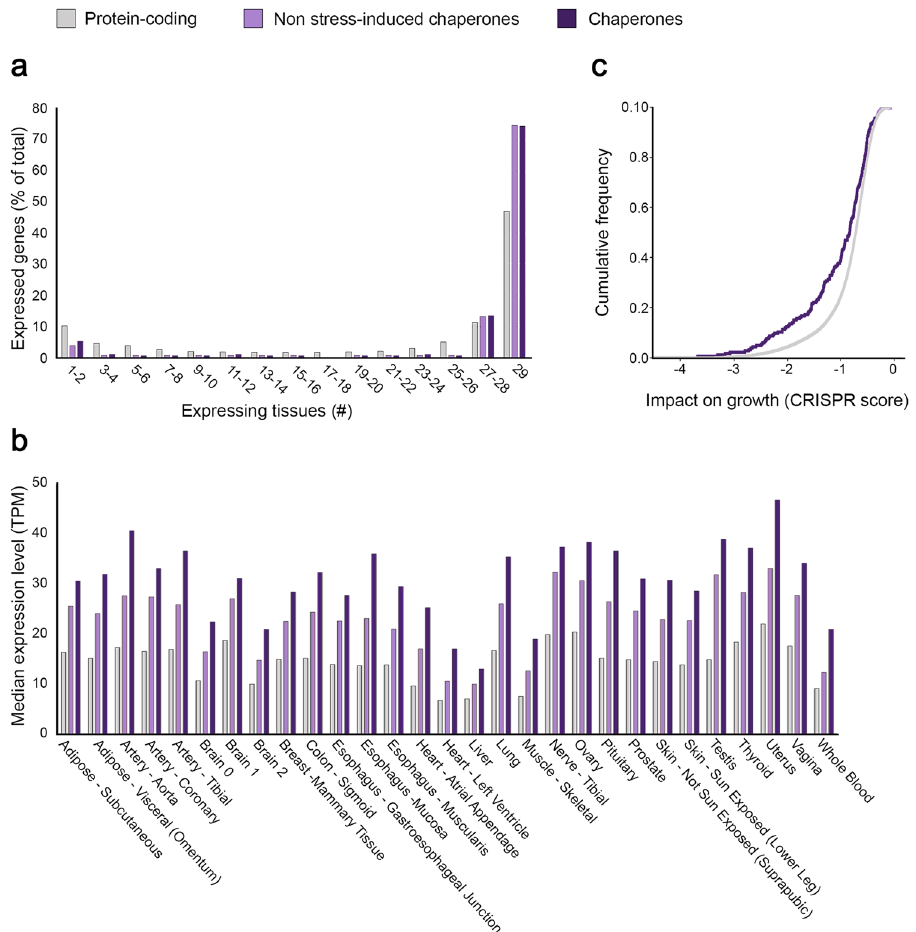
Fig. 1 Chaperones are broadly expressed across human tissues. a The distribution of 194 chaperones, 130 non-stress-induced chaperones and 17,689 other protein-coding genes by the number of tissues expressing them at a level ≥ 1 transcripts per million (TPM; the fi rst bin represents genes expressed in a single tissue or two tissues, the second bin represents genes expressed in three or four tissues, etc.). Chaperones and non-stress-induced chaperones were signi fi cantly more broadly expressed than other protein-coding genes ( p = 2.7E − 9 for both, two-sided Kolmogorov – Smirnov test). b The median expression levels per tissue of chaperones, non-stress-induced chaperones and other protein-coding genes. Only genes expressed at a level ≥ 1 TPM were considered. Chaperones and non-stress-induced chaperones tend to be signi fi cantly more highly expressed across all 29 tissues (adjusted p between 1.7E − 7 and 1.4E − 19, and adjusted p between 0.026 and 4.9E − 8, respectively, two-sided Mann – Whitney test). Chaperones n = 155 – 192; non-stress-induced chaperones n = 102 – 129; other protein-coding genes n = 10,689 – 15,555. c The cumulative distribution of the impact on growth of 186 chaperones and 17,932 other protein-coding genes, measured in 769 cell lines harboring CRISPR-induced gene inactivation (CRISPR score). Each gene was associated with its minimal CRISPR score. Chaperones were signi fi cantly more important for growth than other protein-coding genes ( p = 1.5E − 5, one-sided Kolmogorov – Smirnov test). Source data are provided as a Source Data fi